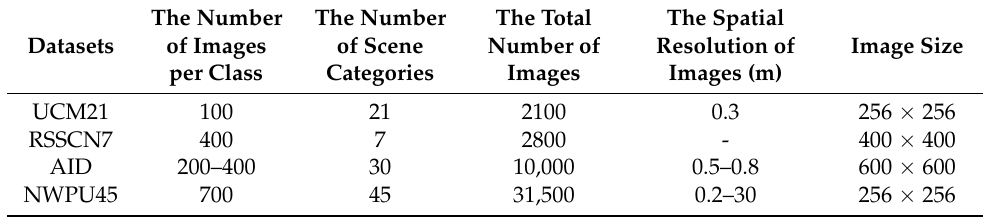
Table 1. Detailed description of four